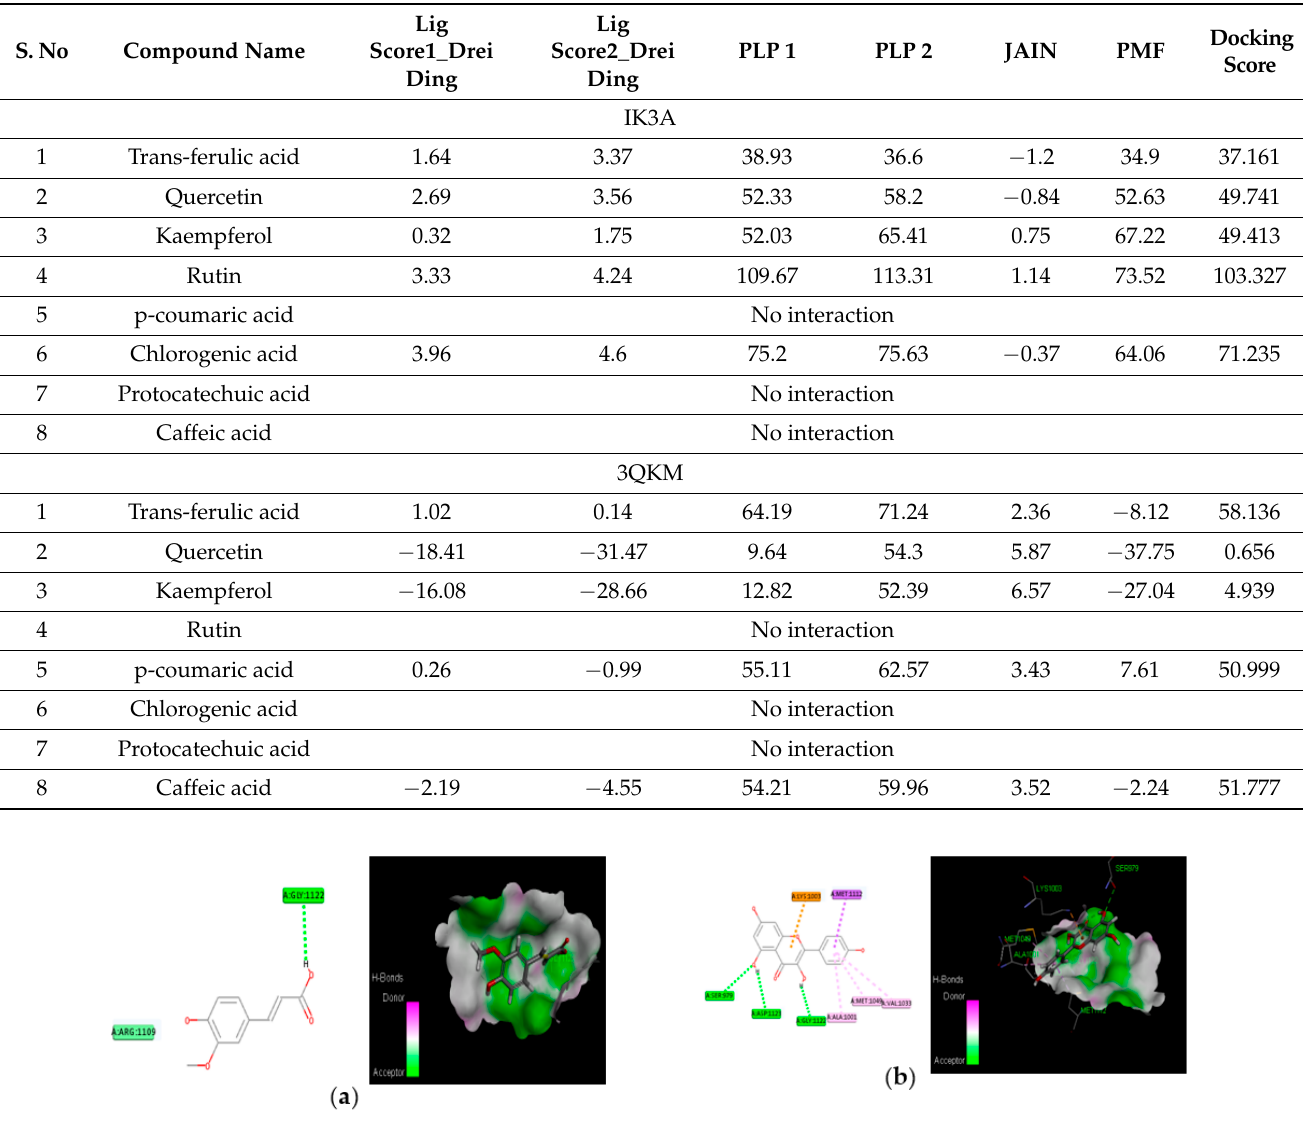
Table 3. Binding affinity assessment based on docking score of proposed natural compounds and selected target proteins.